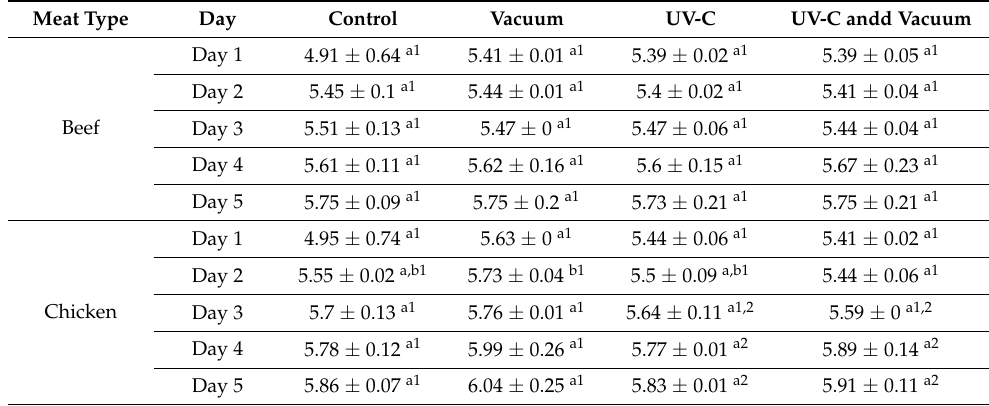
Table 4. The one-way ANOVA analysis and Tukey HSD result, with the mean pH values of the beef, chicken, and salmon